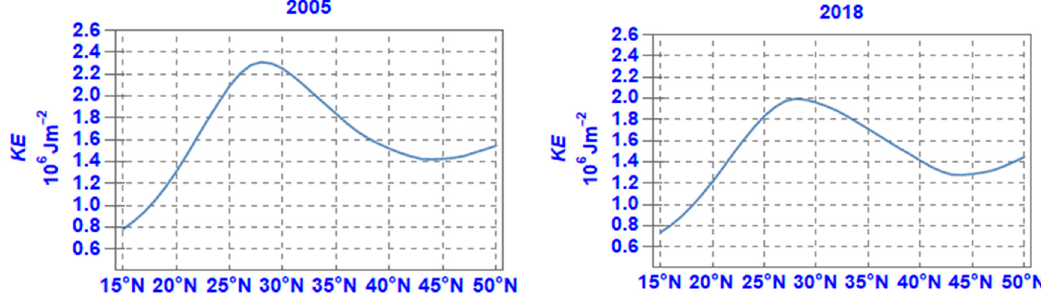
Figure 3. The latitudinal distribution of the zonal average of the annual mean of KE for selected years.